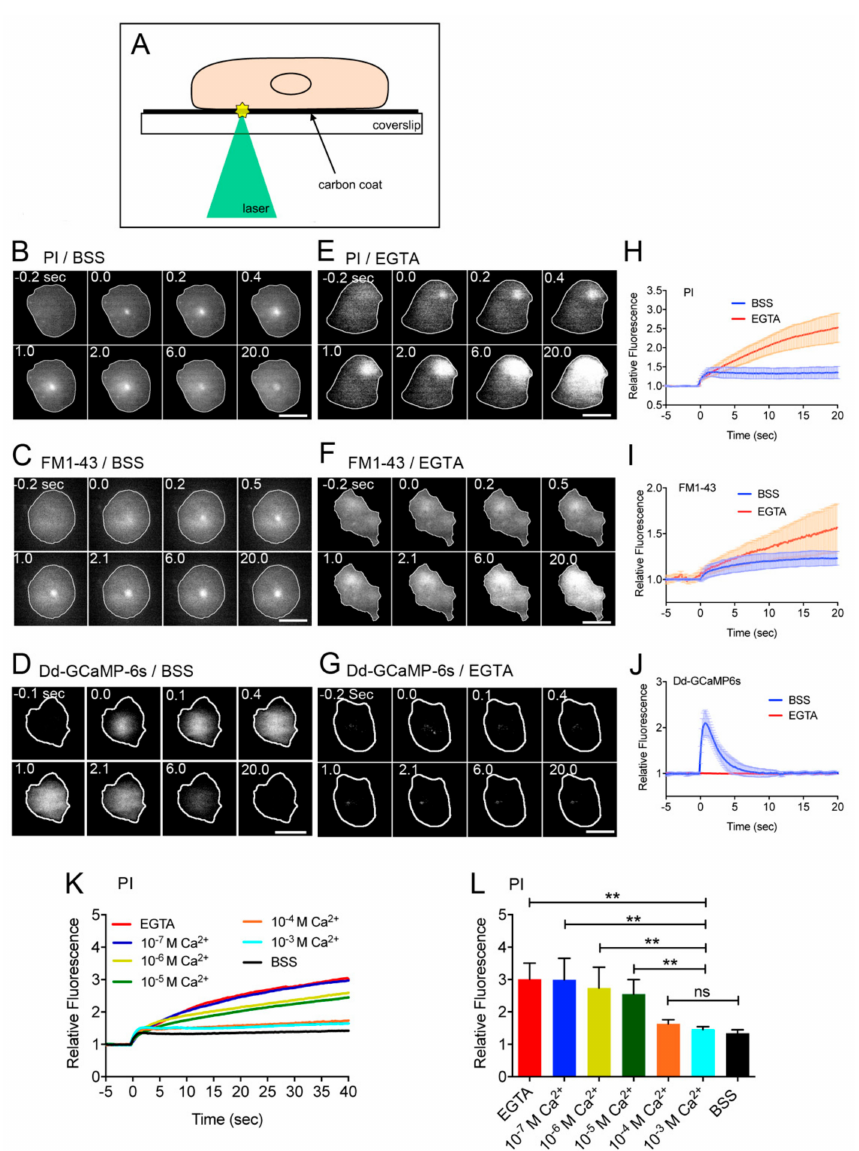
Figure 1. Ca 2 + influx from the wound pore is essential for the wound repair. ( A ) To make a wound in the cell membrane, after cells were placed on a carbon-coated coverslip, a laser beam was focused on a small local spot beneath a single cell under a TIRF microscope. The wound size was set at 0.5 µ m in diameter. ( B , E ) Typical sequences of fluorescence images of propidium iodide (PI) influx after laserporation in the presence ( B ) and absence ( E ) of Ca 2 + . The cells (outlined with white line) were wounded at 0 sec. ( C , F ) Typical sequences of fluorescence images of FM1-43 influx after laserporation in the presence and absence of Ca 2 + . ( D , G ) Typical sequences of fluorescence images of cells expressing Dd–GCaMP6s after laserporation in the presence and absence of Ca 2 + . ( H ) Time course of PI influx in the presence and absence of Ca 2 + . ( I ) Time course of FM1-43 influx after laserporation in the presence and absence of Ca 2 + . ( J ) Time course of the fluorescence intensity of cells expressing Dd–GCaMP6s after laserporation in the presence and absence of Ca 2 + . ( K ) Time courses of PI influx in the various free Ca 2 + concentrations in the external medium. ( L ) A dependency of the PI influx on the free Ca 2 + concentration in the external medium. The relative fluorescence intensities 40 sec after wounding were plotted versus each Ca 2 + concentration. Data are presented as mean ± SD (n = 25, each). ** p ≤ 0.0001; ns, not significant, p > 0.05. Bars, 10 µ